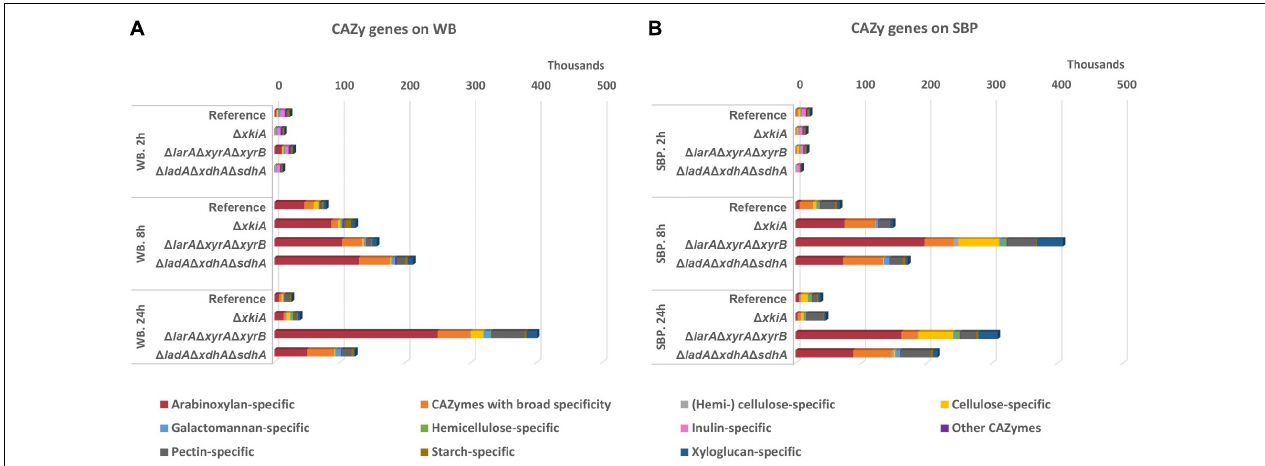
FIGURE 5 | Expression levels (FPKM) of genes encoding CAZymes during growth on (A) wheat bran (WB) and (B) sugar beet pulp (SBP) in the A. niger reference strain (N593 (cid:49) kusA ) and the PCP deletion mutants.